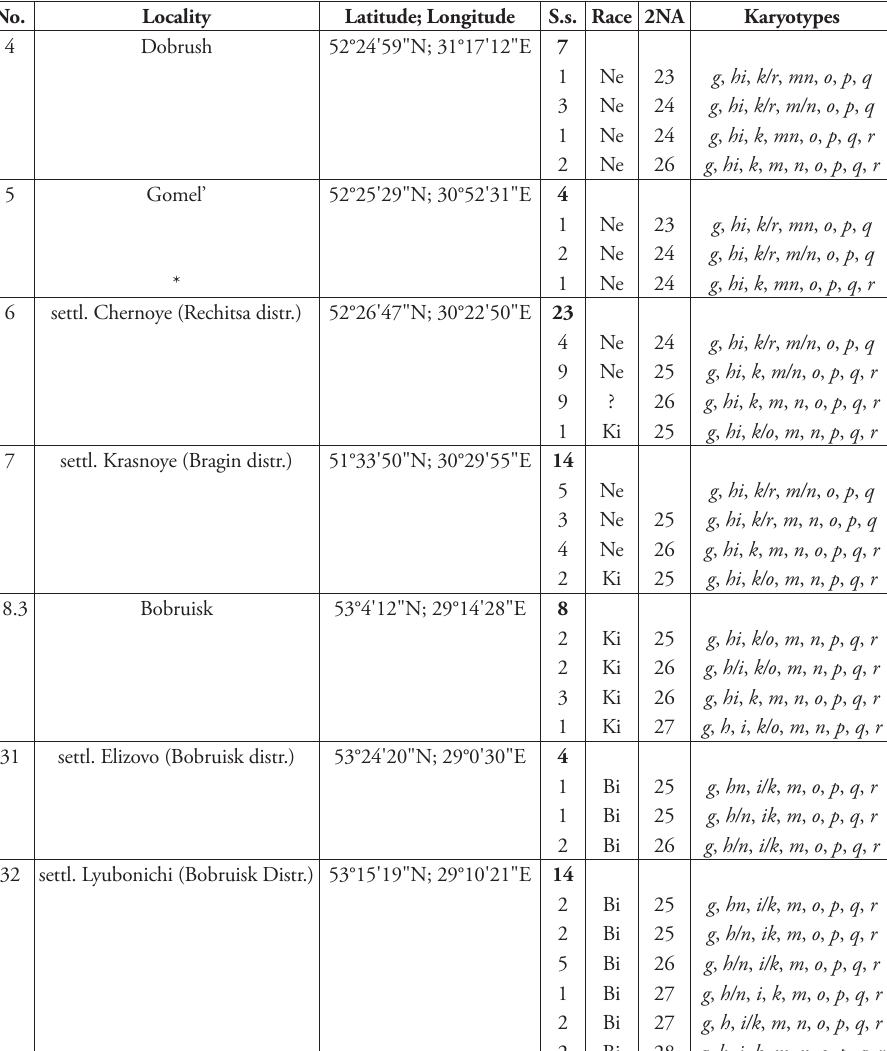
Table 1. Collection sites, chromosome races and karyotypes of common shrews in the territory of Be- larus. The numbers indicate localities in Fig. 1. Polymorphism for Rb translocation is indicated by slash (/). Ne, Neroosa; Ki, Kiev; Bi, Białowieża; Wd, West Dvina; Bs, Borisov. S.s., sample size; ?, attribution to any race is unclear. Locality Latitude; Longitude S.s. Race 2NA